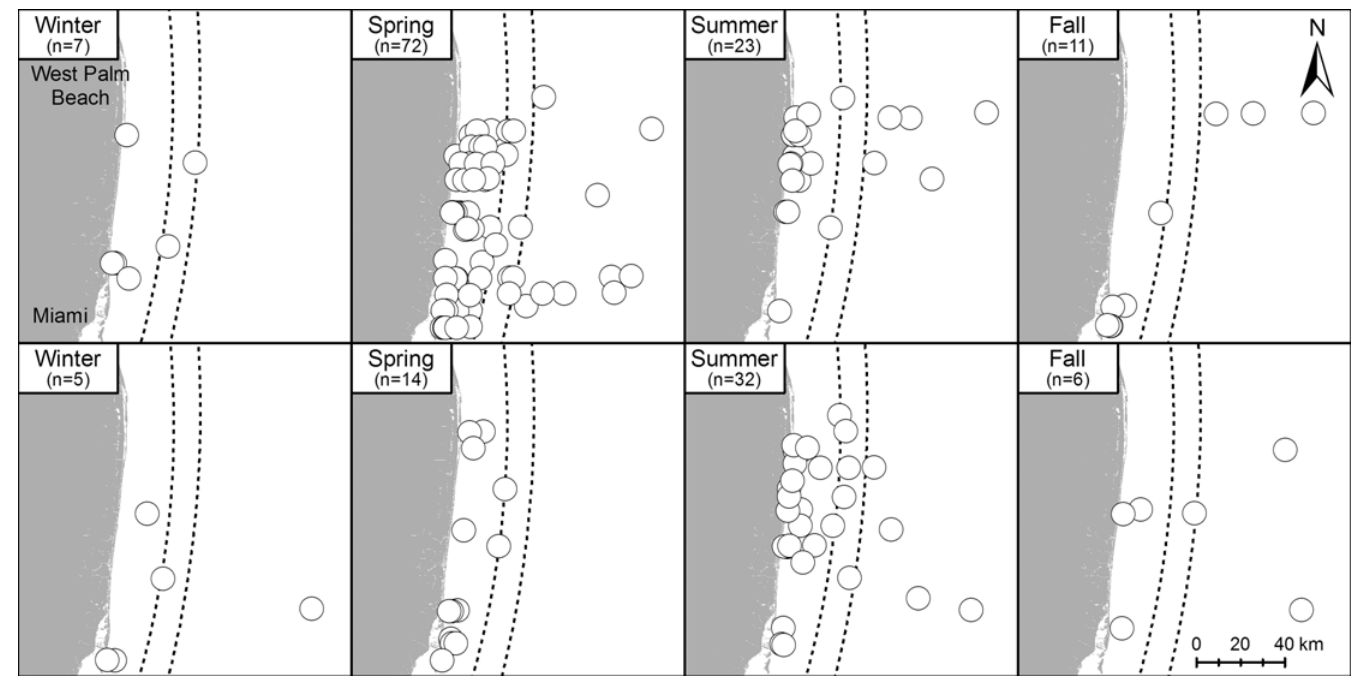
Fig 3. Sightings of the two most commonly observed sea turtle species in 2011 – 2012 by season. Loggerheads (top panels) and green turtles (bottom panels) sighted in each season during 2011 – 2012 aerial surveys. Note that the highest numbers of loggerheads sighted is in the spring while the highest numbers of green turtles sighted is in the summer. Each symbol represents a single sea turtle. Dotted lines represent the approximate location of the core of the Florida Current. Source: Florida Fish and Wildlife Conservation Commission-Fish and Wildlife Research